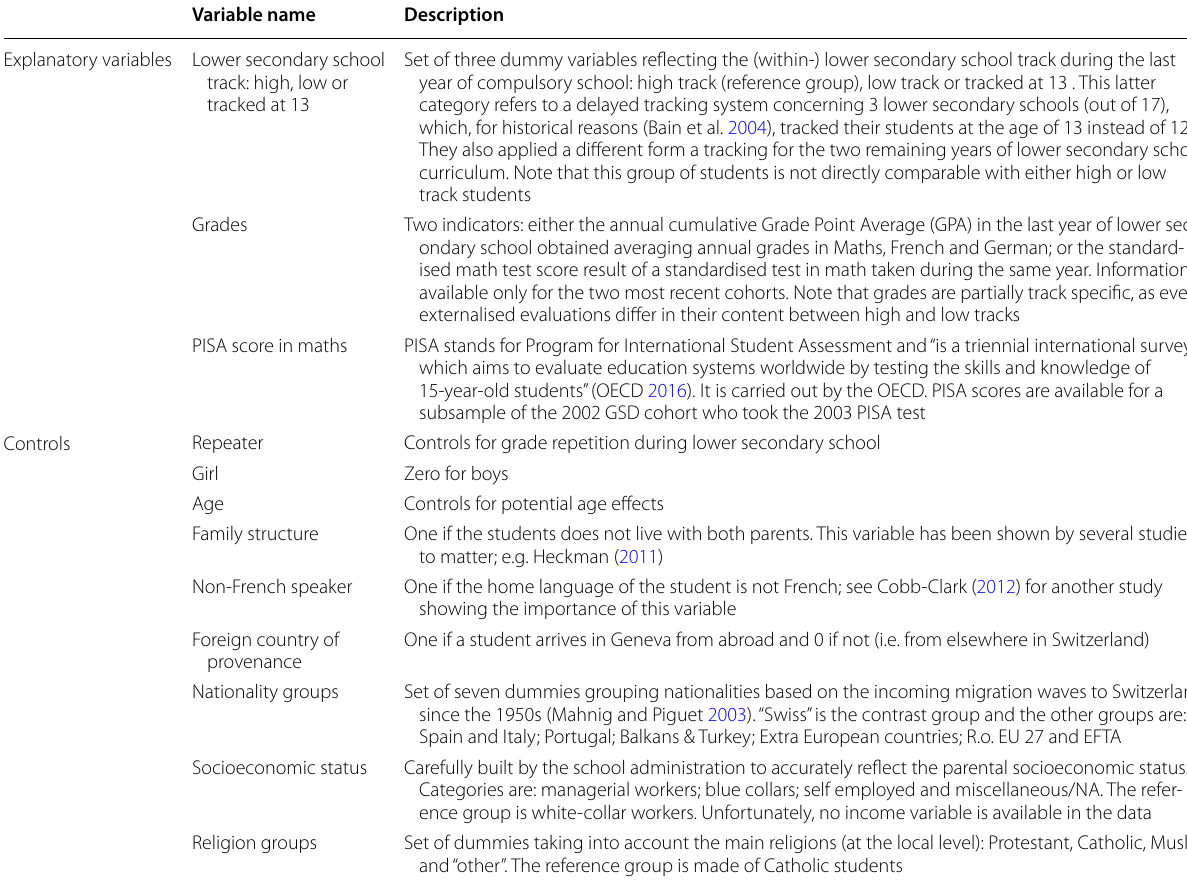
Table 5 Description of independent